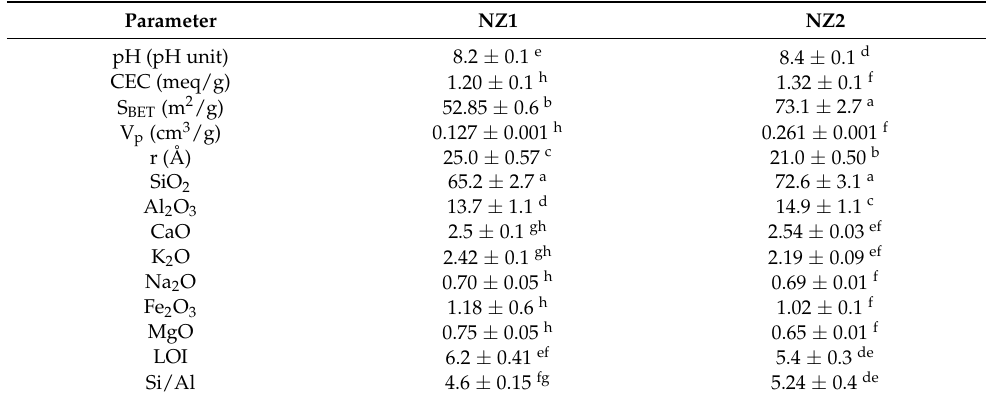
Table 2. Physical and chemical composition (% w/w ) of zeolites used in the experiments (mean ± stan- dard deviation, n = 3).